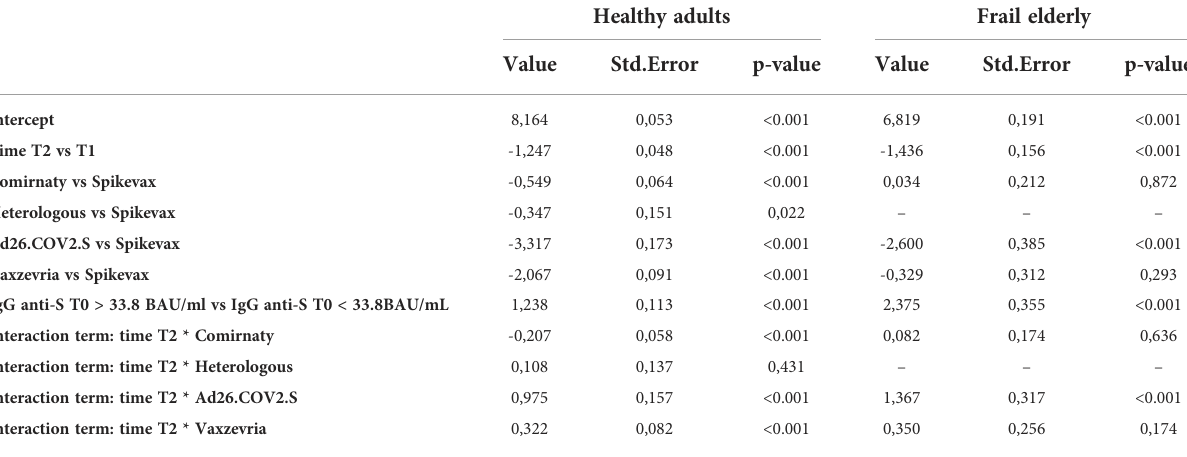
TABLE 4 Estimated fi xed effect of the mixed effect log-linear model on the GMT with time, type of vaccine, a dichotomous variable indicating whether IgG anti-S T0 > 33.8 BAU/ml, and age group as covariates, and an interaction term between time and type of